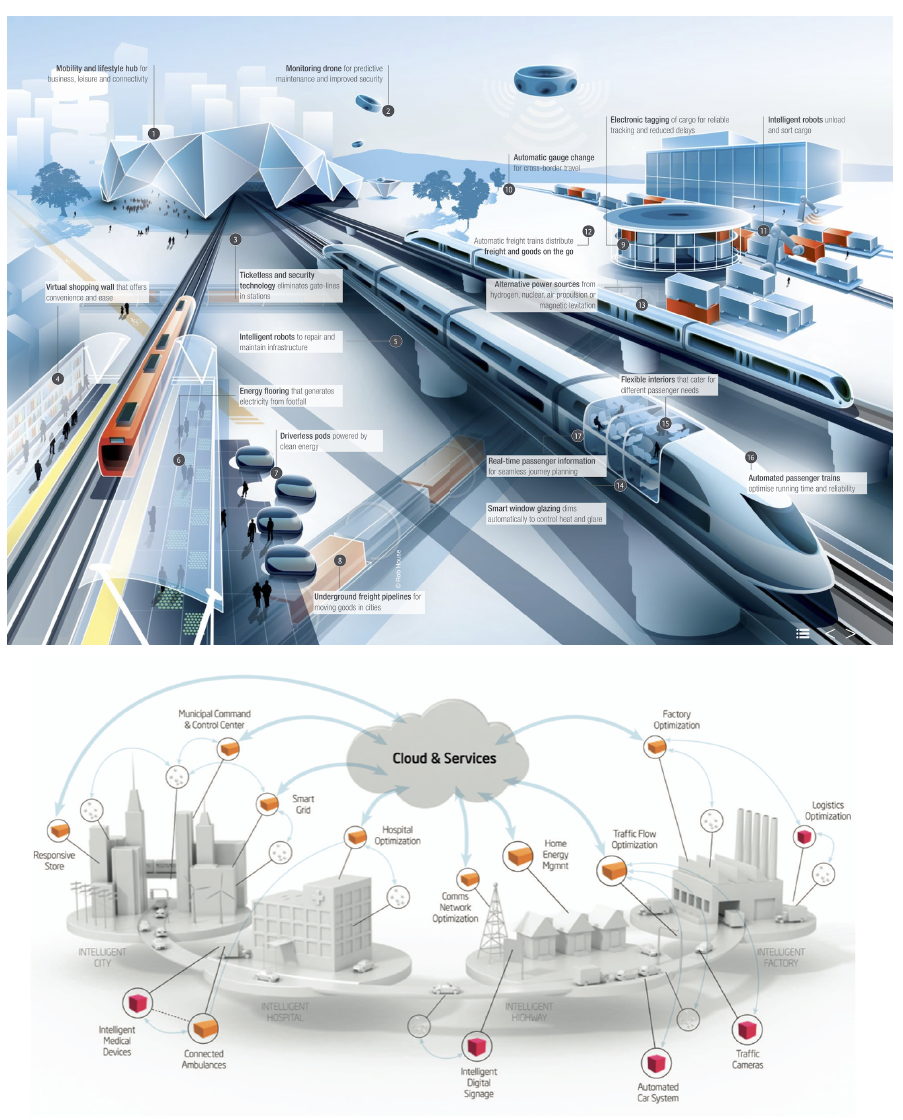
Figure 3. Different views of Smart Cities. Currently in-development system, including fixed smart dust, mobile smart dust, users’ smart phones, control center and system administrator could be easily integrated. (Reprinted with kind permission from http://www.cnet.se/smart-cities and https: